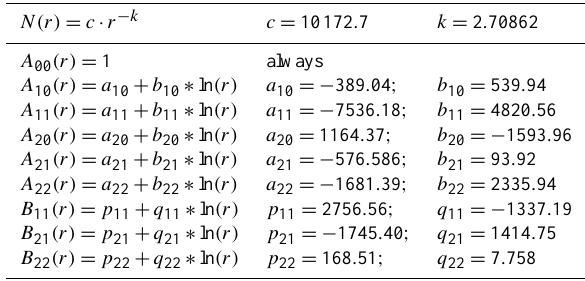
Table 4. Summer-solstice model fit coefficients.